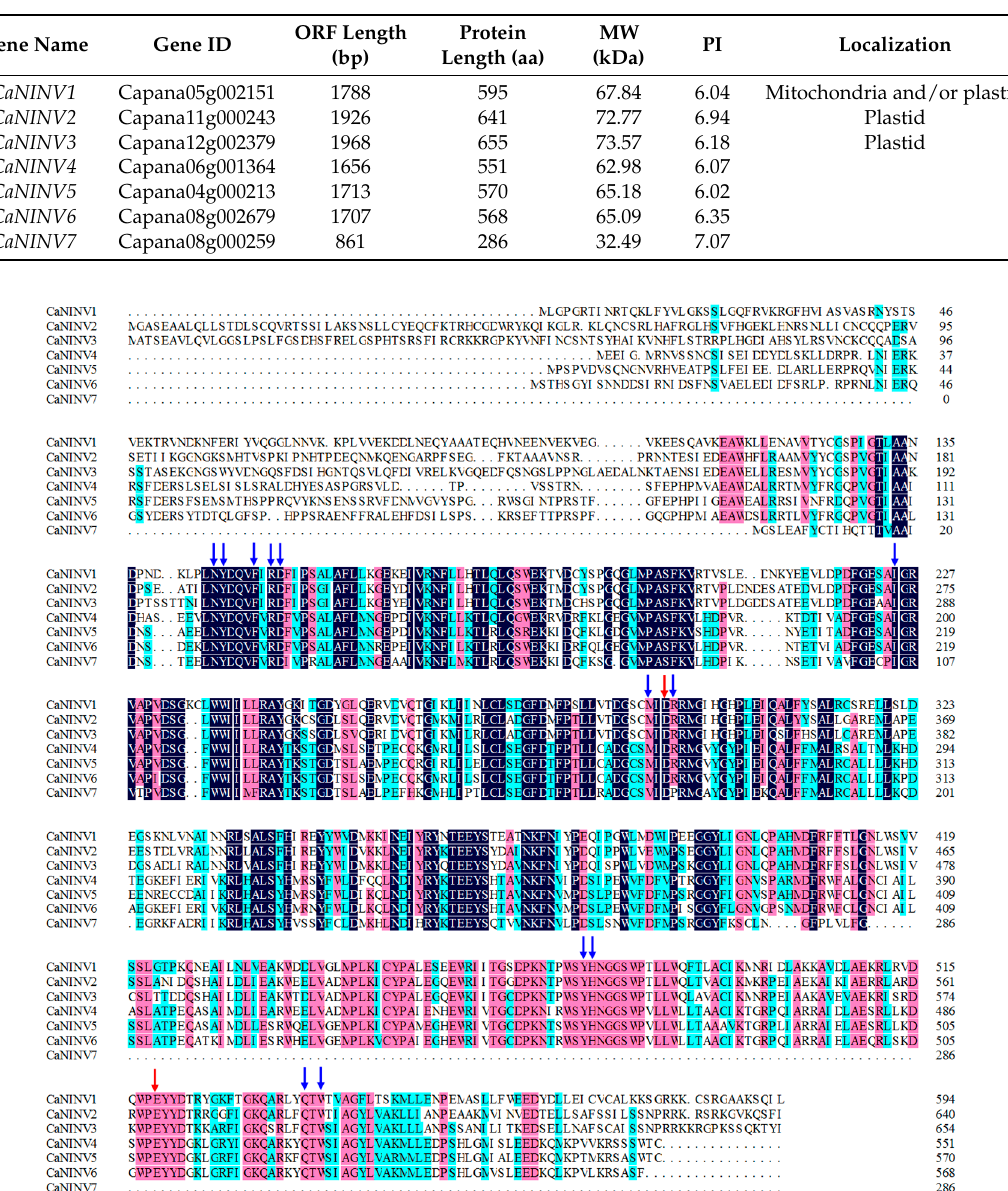
Figure 1. Alignment of the deduced amino acid sequences of the seven pepper neutral/alkaline invertases. Dark-blue shading, pinkish shading and light blue shading reflect 100%, 75% and 50% amino acid residues conservation, respectively. The catalytic residues and substrate-binding residues are depicted by red and blue arrows, respectively.